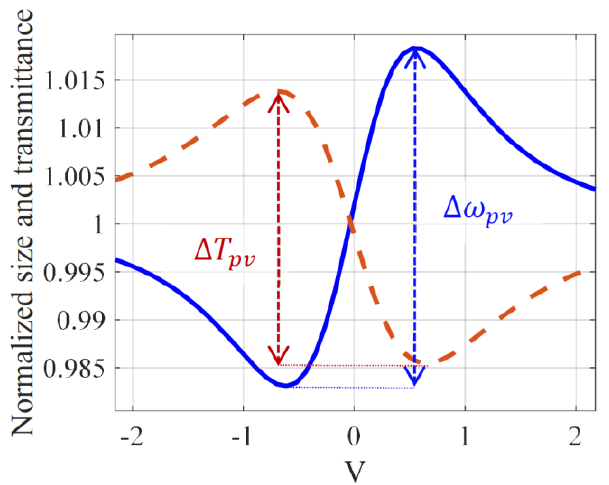
Figure 7. (color online): The relative size variation in solid (blue) line and the normalized Z-scan transmittance in dashed (red) line versus the position of the cell. The blue curve is shifted to 1. One could notice that the sensitivity of D4 σ and Z-scan methods are almost the same.